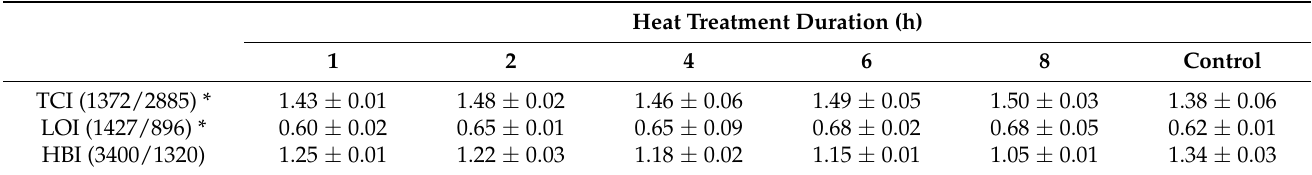
Table 6. Infrared crystallinity ratio (LOI and TCI) and hydrogen bond intensity (HBI) of cellulose in heat-treated